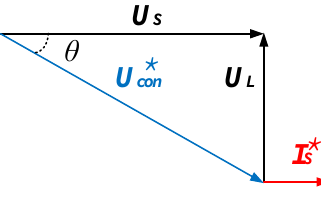
Figure 5. Phasor diagram on the AC side under unity power factor.